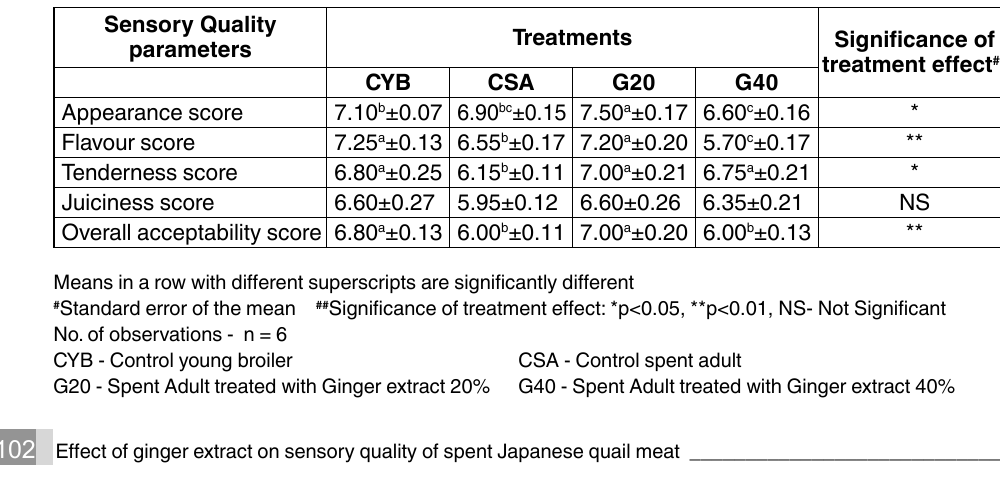
Table 3. Effect of ginger extract marination of spent Japanese quail meat on the